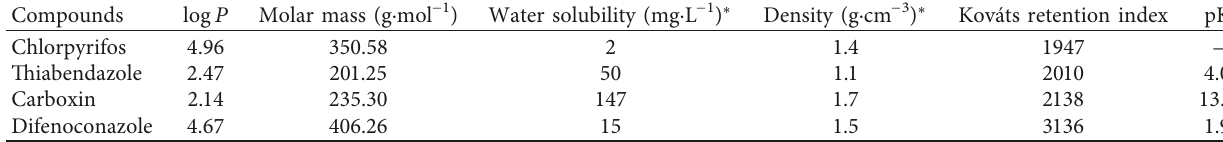
Table 1: Physicochemical properties of the studied pesticides.